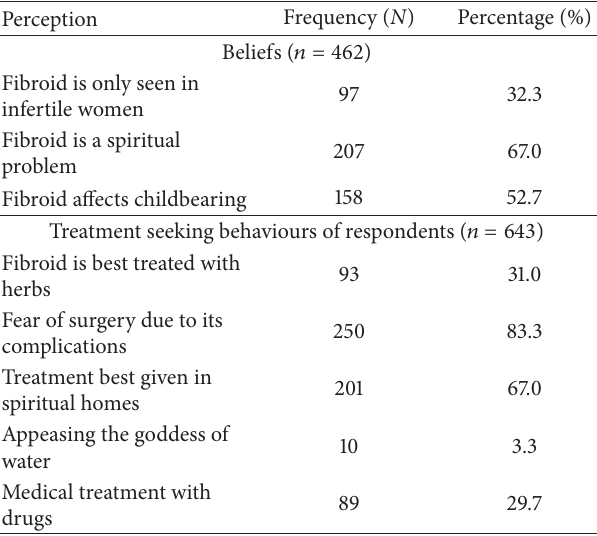
Table 2: Clinical features in the respondents ( 𝑛 = 300 ).